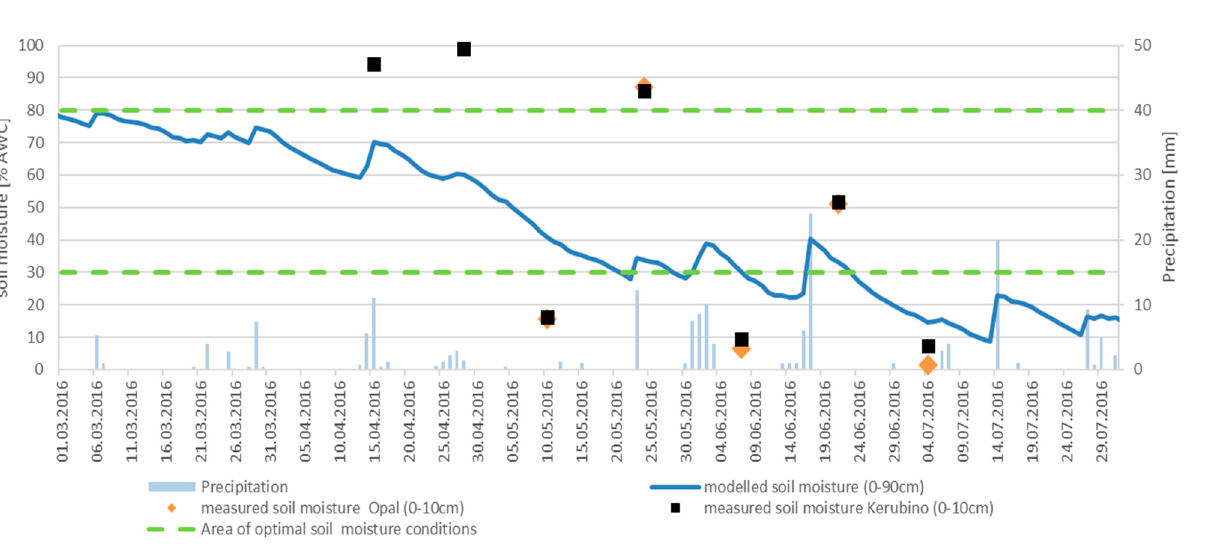
Figure 7. Modeled and measured soil moisture [% AWC] of irrigated winter wheat plots Opal and Kerubino and precipi ‐ tation [mm] in the period March to July 2016. Differences between the irrigated and unirrigated plots could be seen in the biometric parameters. At the onset of flowering (GS 60) and during dough development (GS 80), the winter wheat plants on the irrigated plots were ~13 cm higher than on the unirrigated plots (Figure 8). Averaged over the entire growing season, the irrigated plots of both winter wheat varieties were 5 cm higher. The measurements of the leaf area index showed an almost identical course. The leaf area index decreased by 0.5 units during the dry period of the stem elongation (GS 30–39) in May on the unirrigated plots. At the time of flowering (GS 60), the highest values between 3.6 and 4.0 were achieved for the leaf area index (Figure